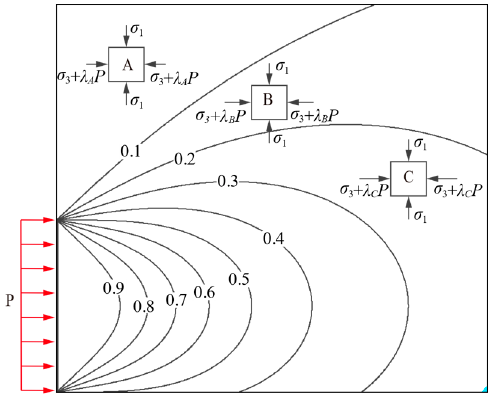
Figure 7. Influence of additional stress at each point in the coal pillar.